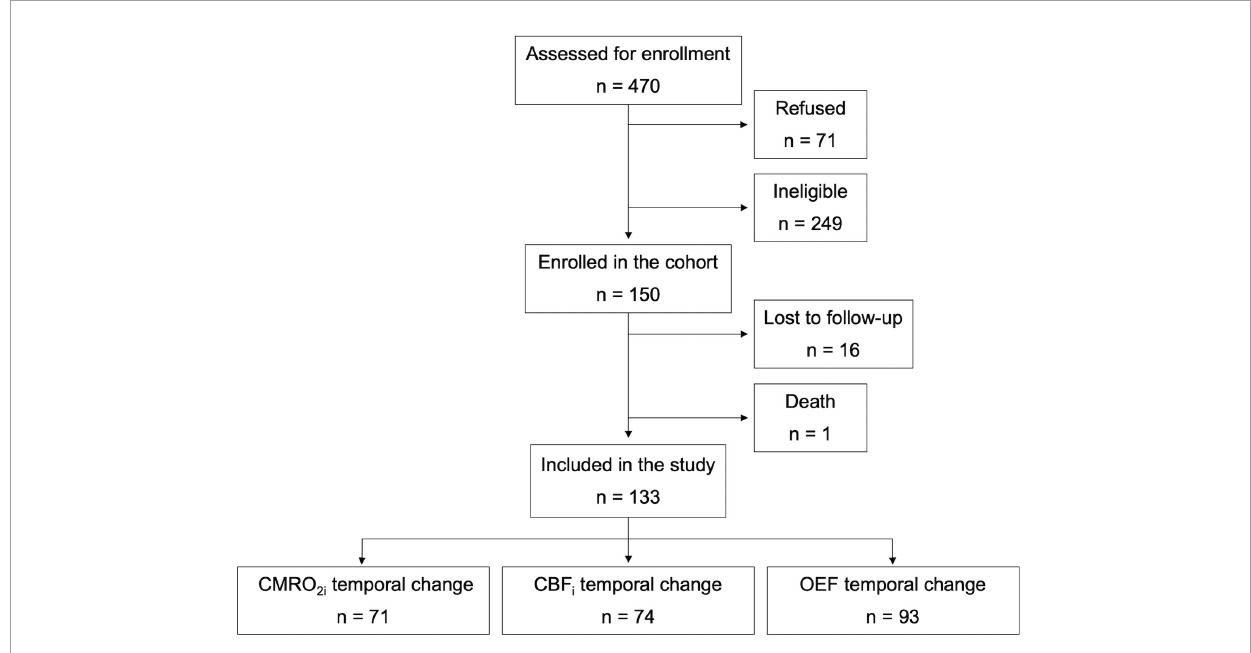
FIGURE1 Flow chart of